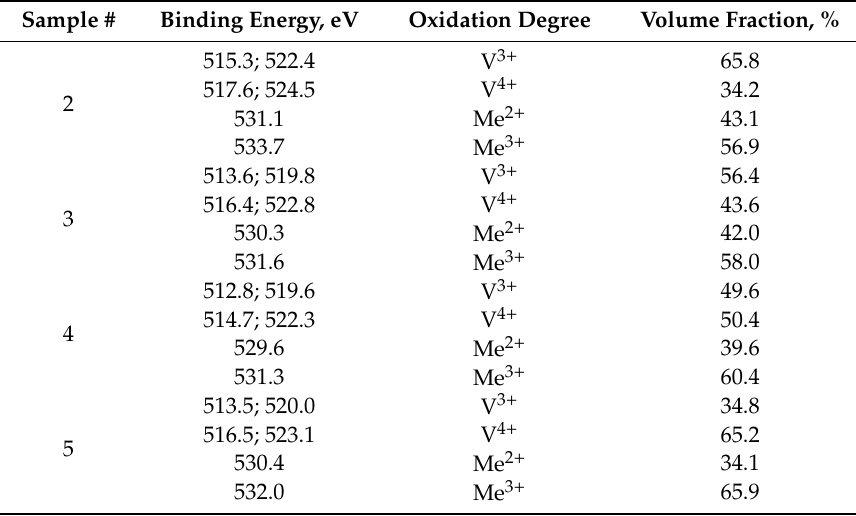
Table 3. Content of elements with di ff erent oxidation degrees in